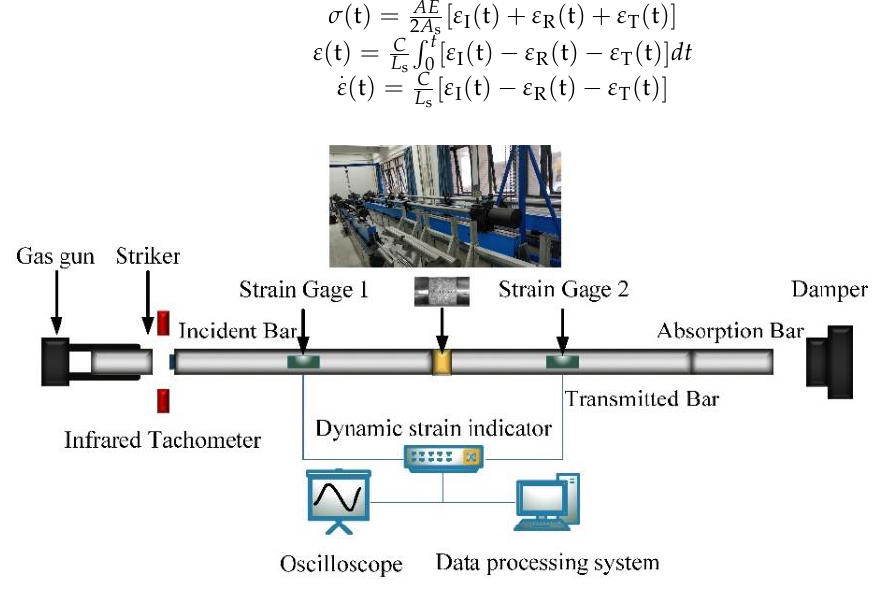
Figure 3. Schematic diagram of SHPB device. In this set of equations, ε I ( t ) , ε R ( t ) and ε T ( t ) represent the incident pulse signal, reflected pulse signal, and transmitted pulse signal, respectively, A , E, and C correspond to the cross-sectional area, Young’s modulus, and P-wave velocity of the elastic bars in turn, and A s and L s stand for the cross-sectional area and length of the sandstone